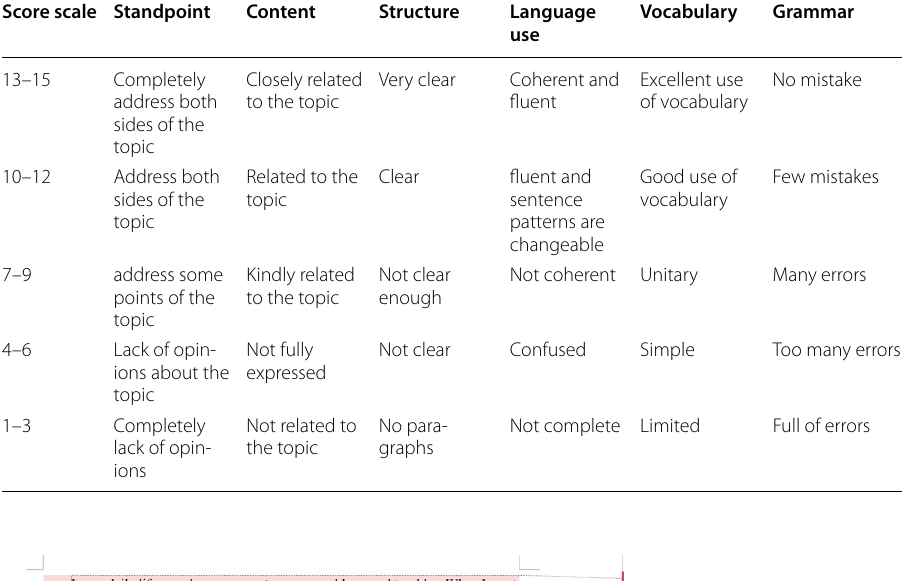
Table 2 The Rubric of essay writing scoring for the instructor Score scale Standpoint